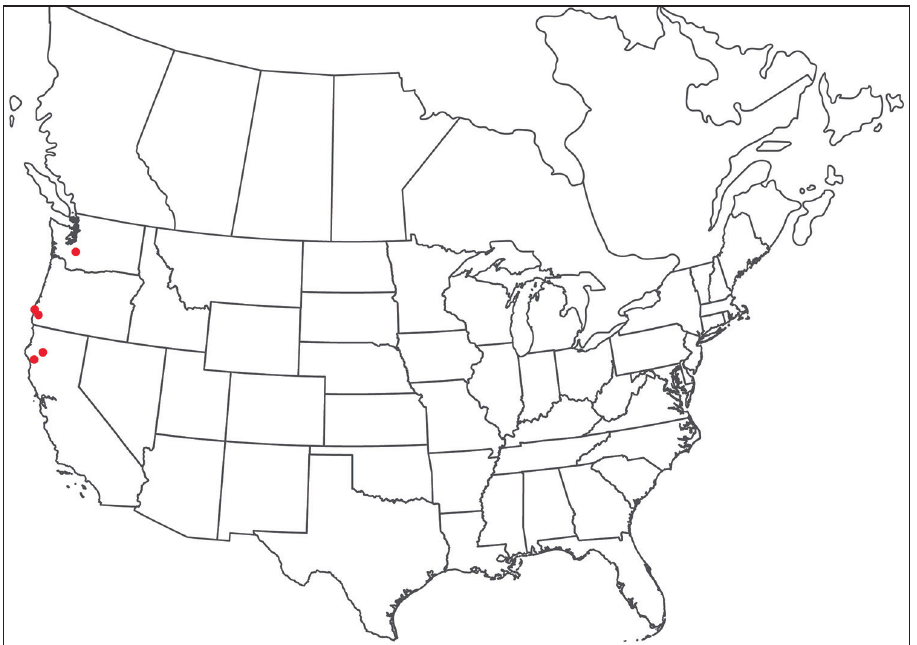
Figure 172. Torrenticola oliveri sp. n.